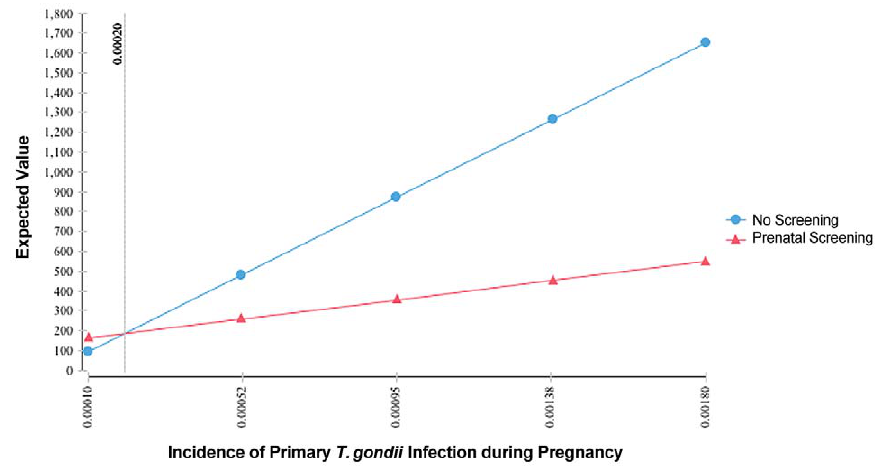
Figure 5. Sensitivity analysis of incidence of primary T.gondii infection during pregnancy.